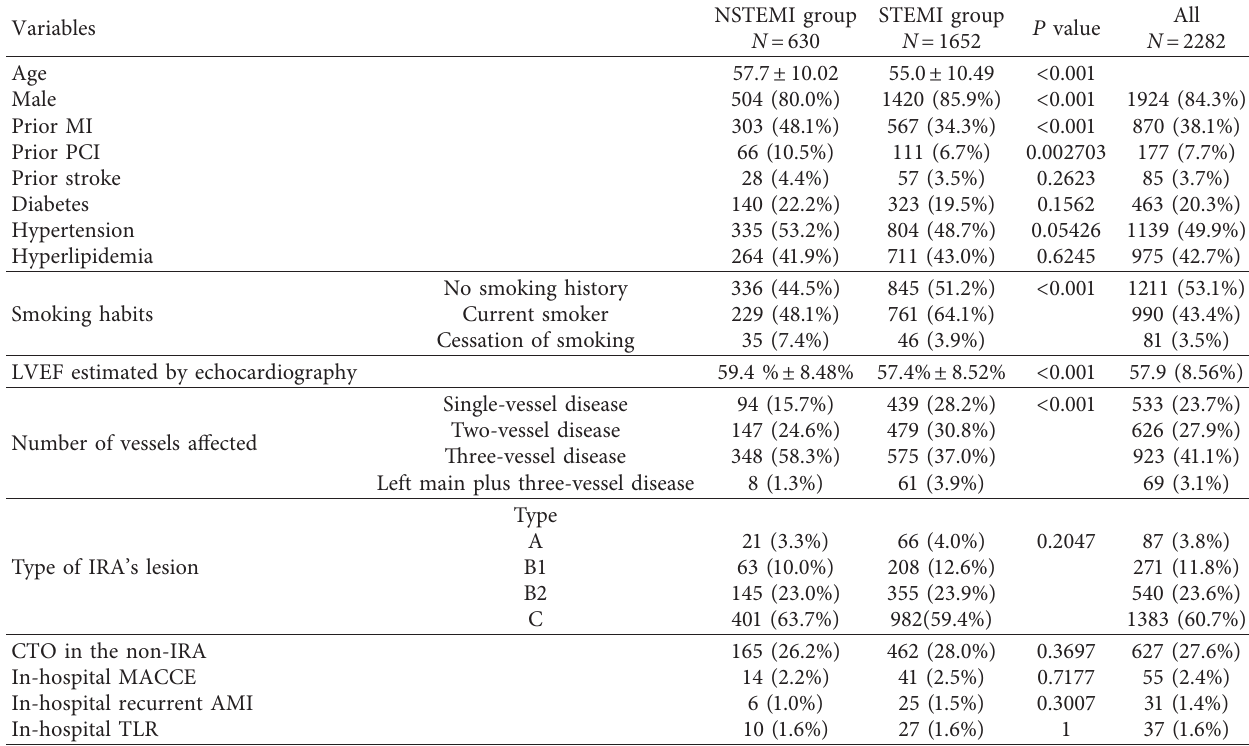
Table 1: Baseline and angiographic characteristics of patients with STEMI or